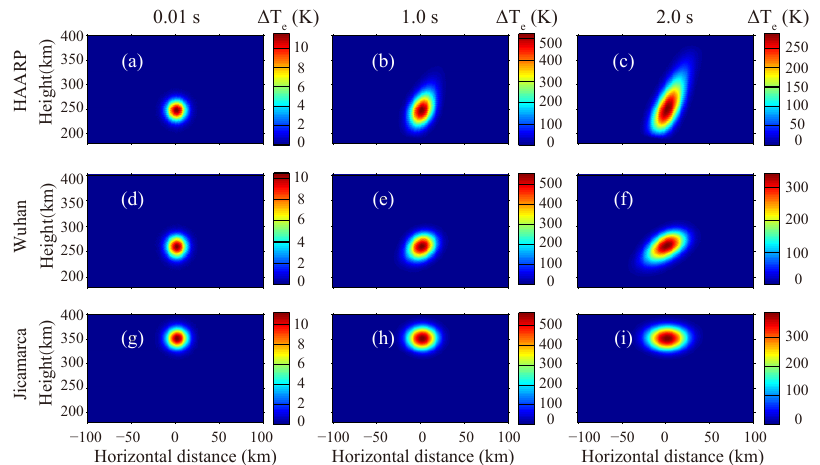
Figure 3. Contours of electron temperature changes with modulation frequency of 0.5Hz at heating time of 0.01, 1.0 and 2.0s in the daytime ionosphere.